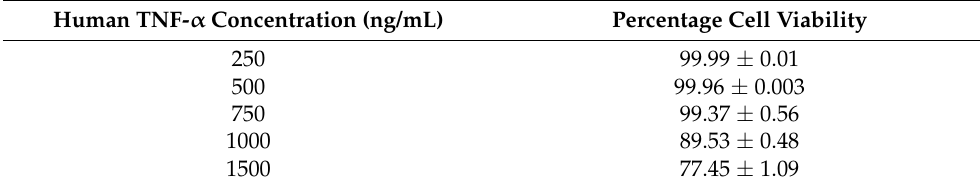
Table 9. Effect of different cell-free synthesized human TNF- α concentrations on viability of PBMCs.